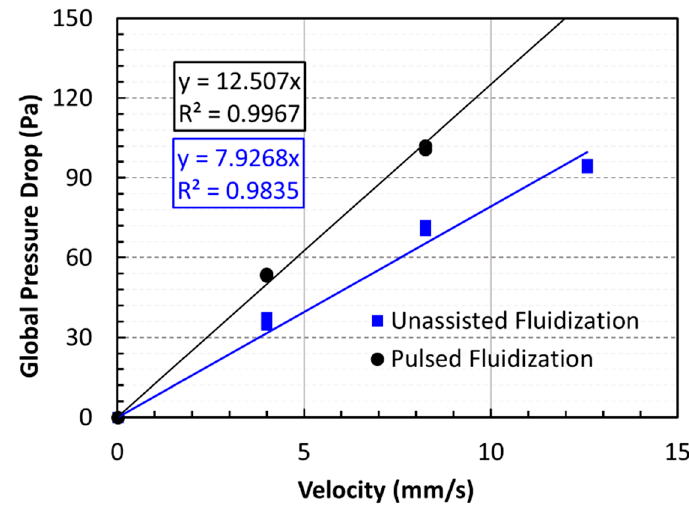
Figure 14. Local pressure drop variations with velocity and corresponding linear-fits for defluidization cycles of pulsed fluidized bed.